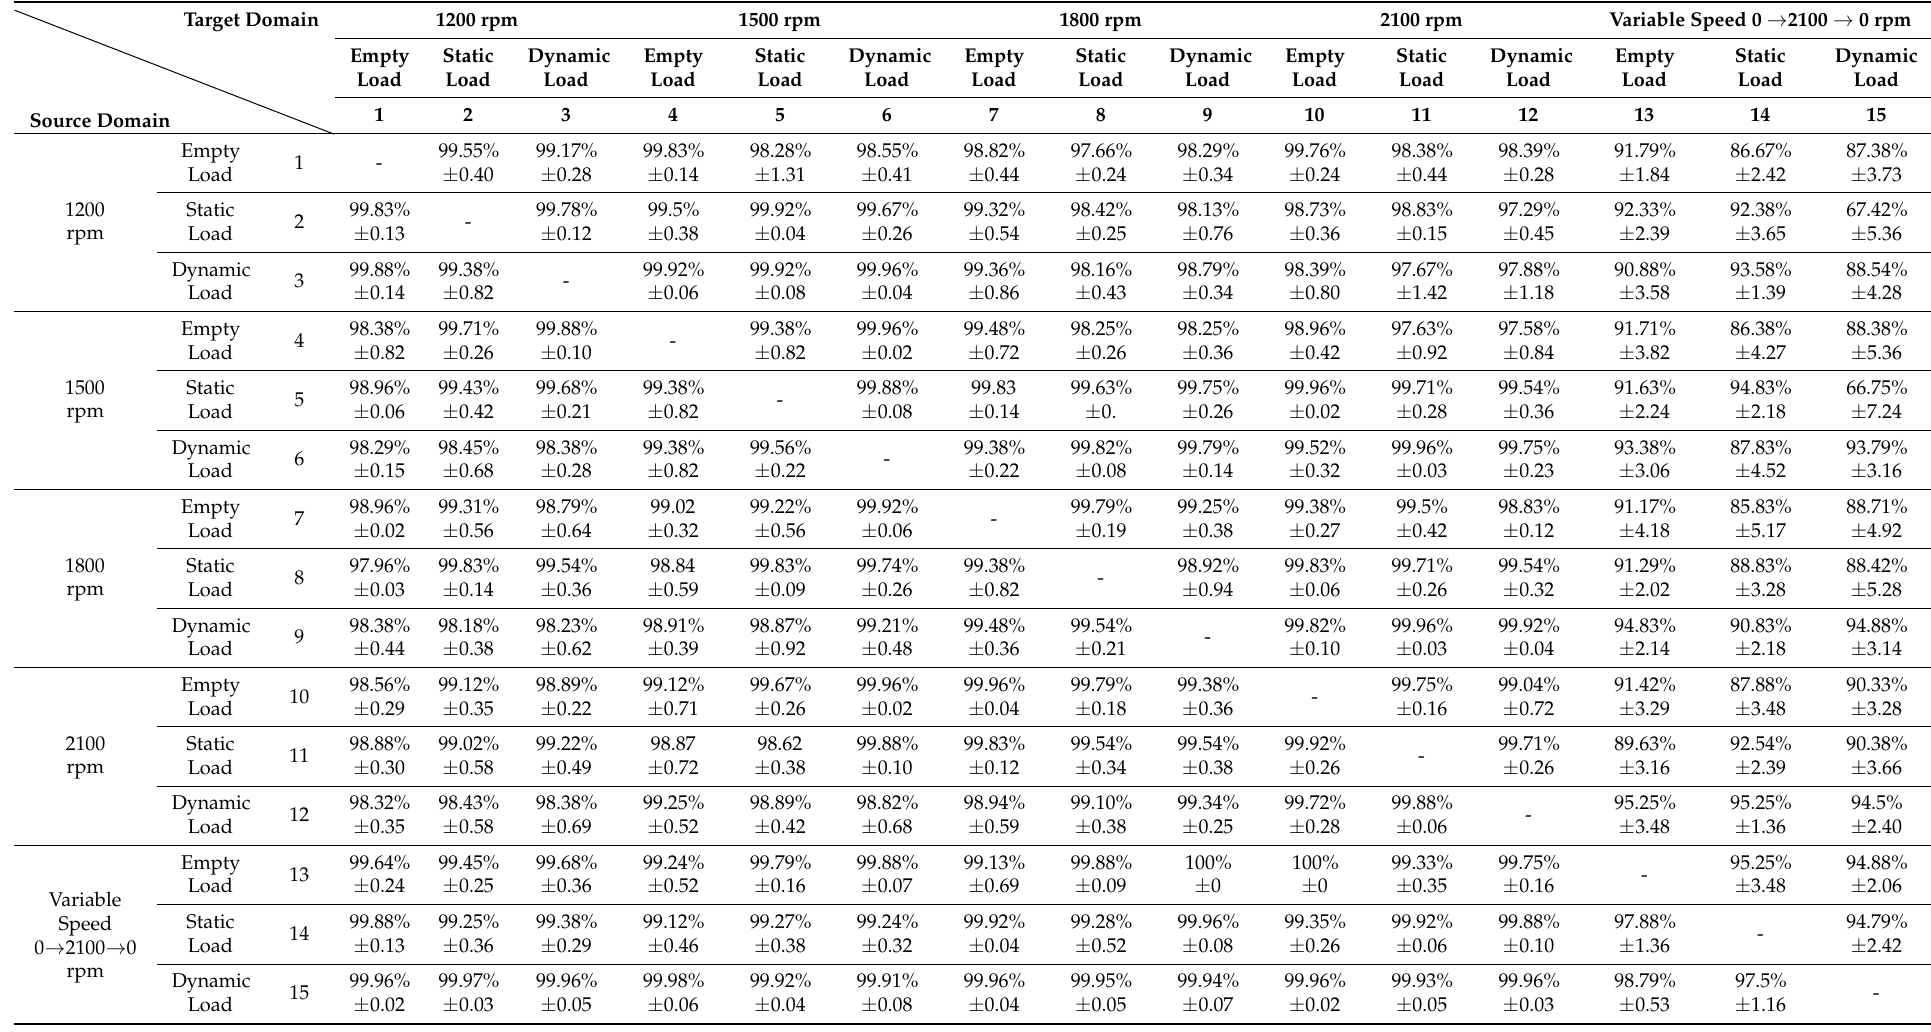
Table 4. Experiment results of the proposed DSTLN